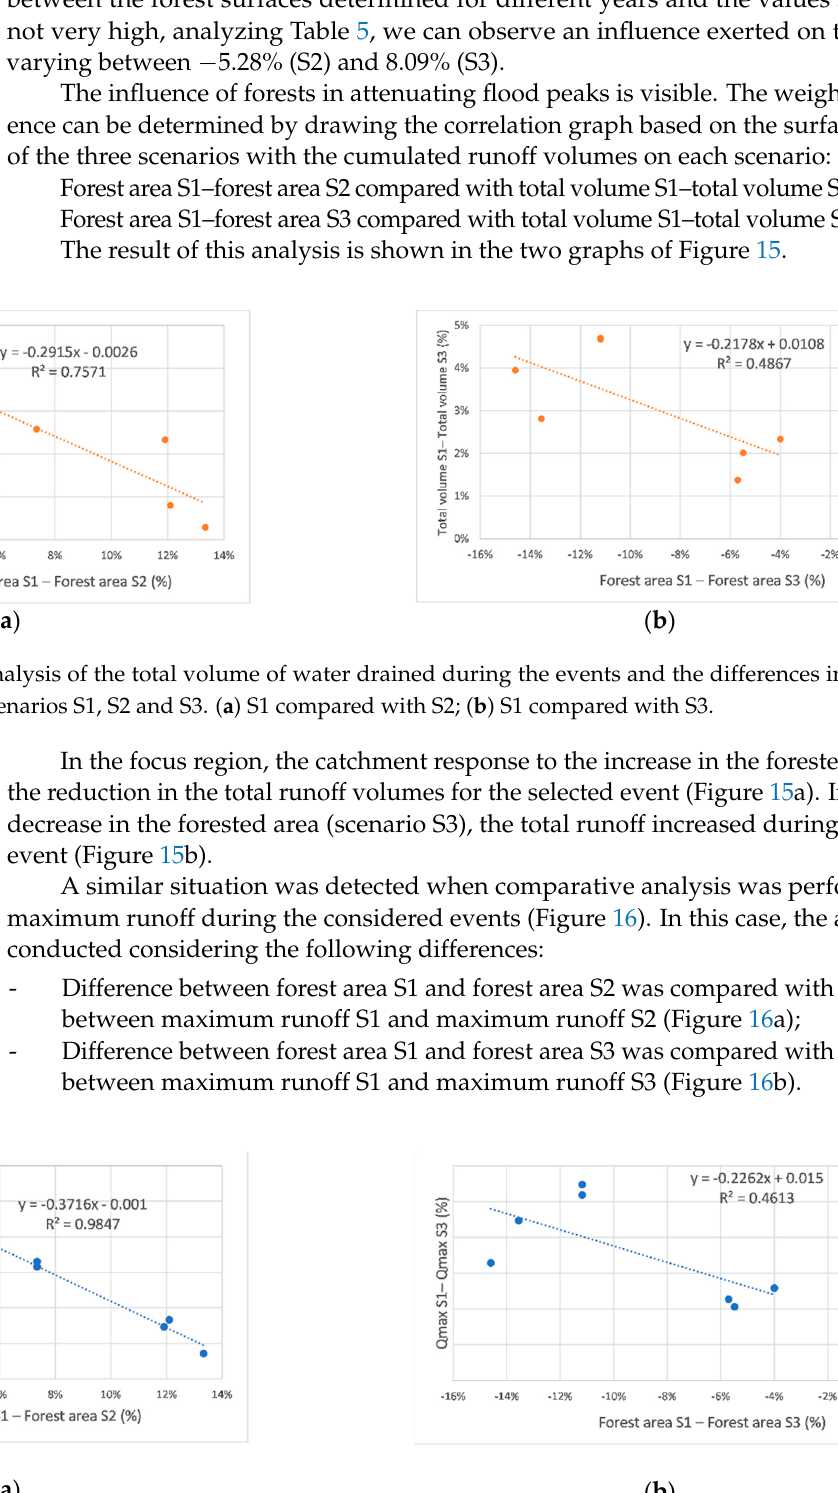
Figure 14. Simulated and observed instantaneous unit hydrograph results. ( a ) Runoff and Q acumulated—1992; ( b ) Run- off and Q acumulated—2001; ( c ) Runoff and Q acumulated—2008; ( d ) Runoff and Q acumulated—2013;